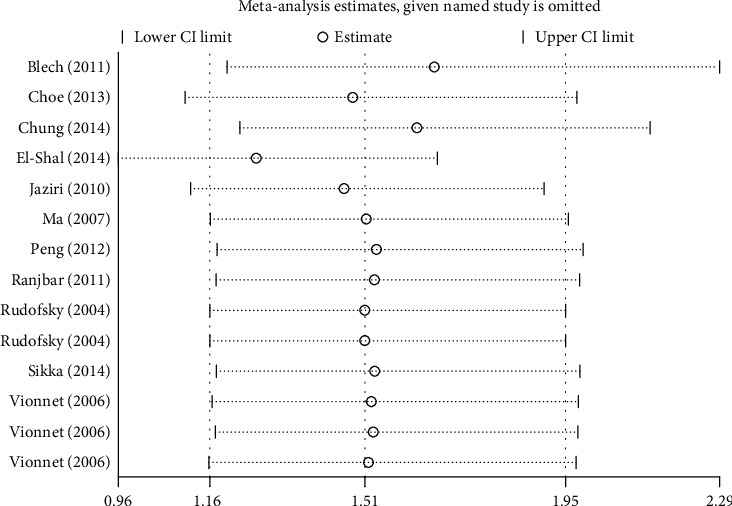
Sensitivity analysis for testing the stability of the overall estimate in the GG vs. TT comparison.